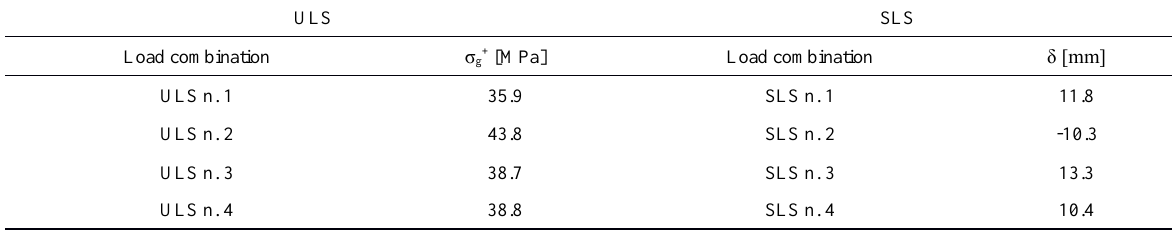
Table 7 lists the maximum horizontal displacement obtained from the SLS load combinations and the maximum values of the tensile from the ULS load combinations. The presence of the glass railings reduces the horizontal deformability of the glazing. Table 7: Maximum values of stresses and horizontal displacement in glass.